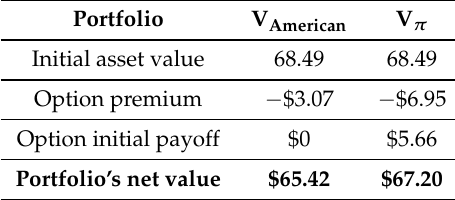
Table 7. Portfolios and their initial net values for the WTI